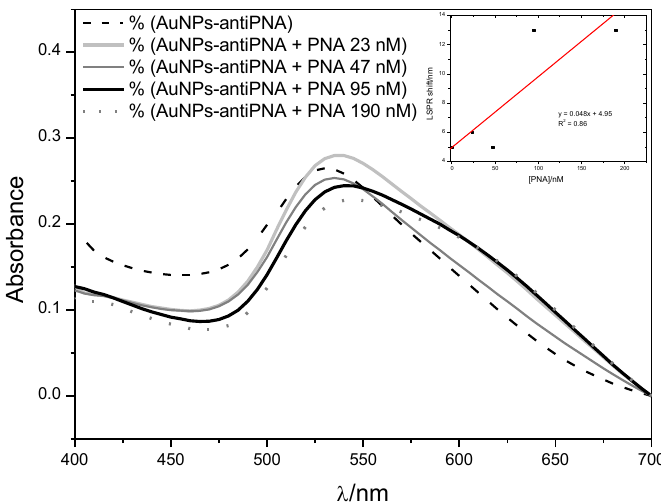
Figure 7. UV-Vis spectra of gold NPs functionalized with antibody anti-PNA after incubation with PNA solution at different concentrations. Insert: Linear fitting of LSPR shift of gold NPs functionalized with antibody anti-PNA as a function of the concentration of PNA in